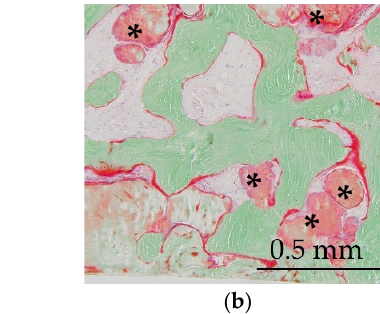
Figure 4. Histological analysis of newly formed bone after SFE (Villanueva–Goldner staining). Mature bone is stained green and osteoid is stained red: ( a ) Low magnification; ( b ) Higher magnification of red square in ( a ). *: residual CO 3 Ap granules.